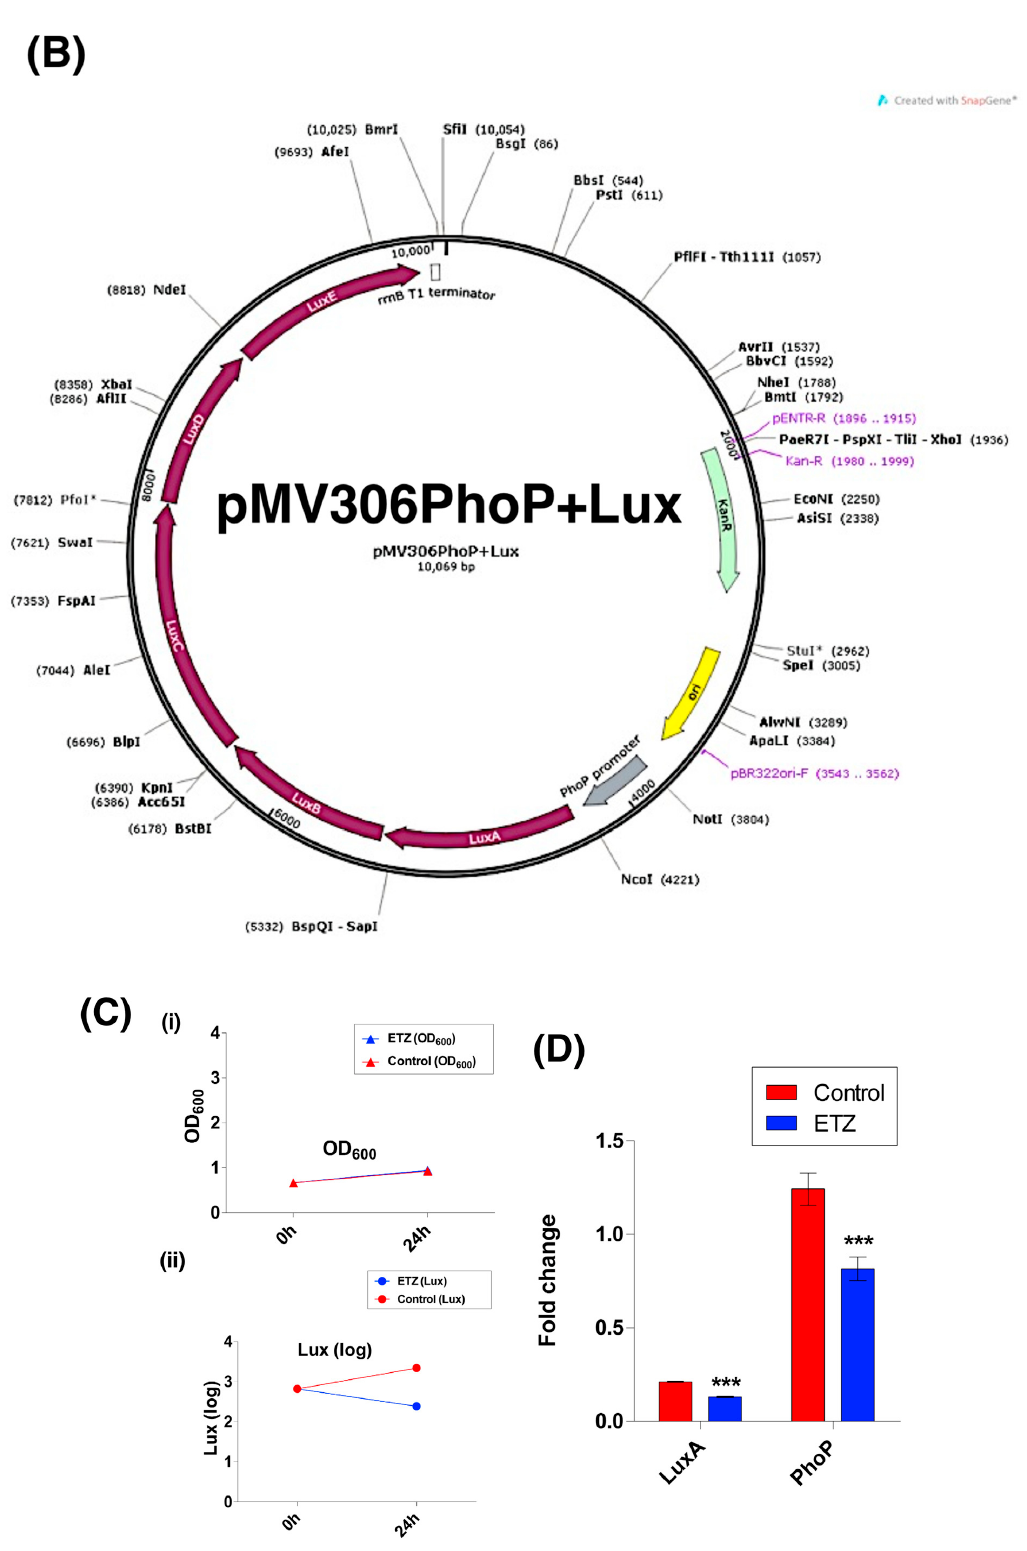
Figure 1. Construction and validation of the lux -based promoter-reporter platform. ( A ) pMV306G13+Lux. ( B ) pMV306PhoP+Lux. ( C ) Mean ( ± SD, n = 3) lux signal (in log lux) and OD 600 in M. bovis BCG with and without (control) ETZ treatment at time 0 h and 24 h. ( D ) LuxA and phoP expression of M. bovis BCG with and without (control) ETZ treatment. Data are presented as means ± SD ( n = 3) and analyzed using an unpaired t -test, *** p < 0.001 vs. BCG without ETZ